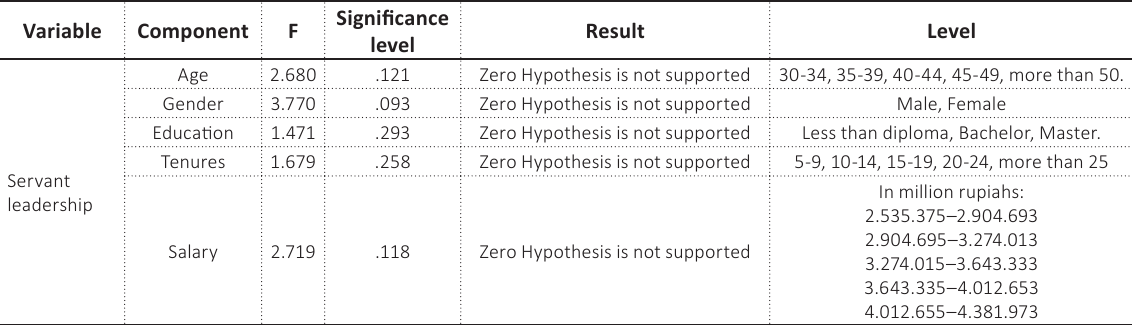
Source: Processed